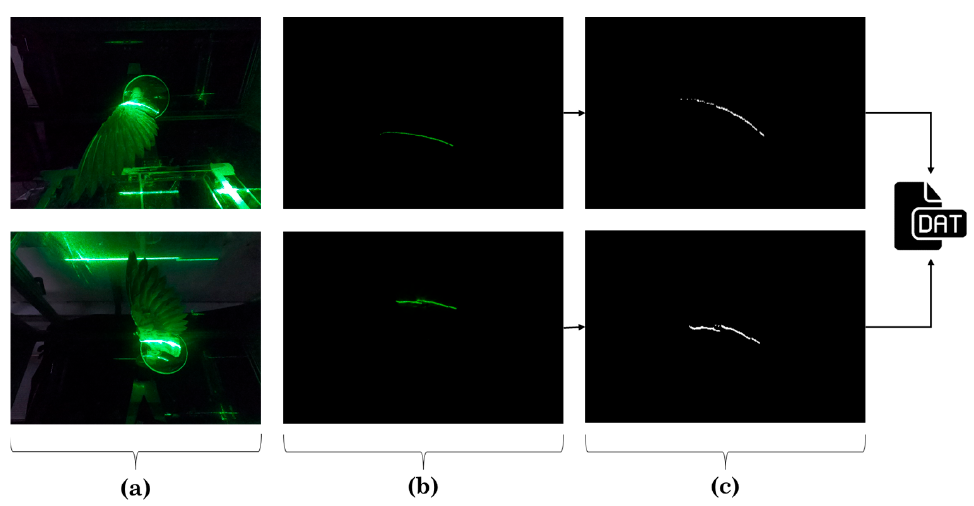
Figure 5. Laser scan methodology: ( a ) Schematic positioning of the cameras, ( b ) Projection of the laser, ( c ) Phyton code black and white images.